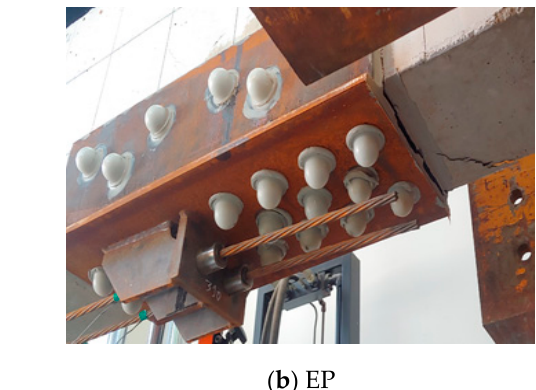
Figure 8. Load–displacement responses for strengthening methods for a concrete strength of 40 MPa for prestressing at 140 and 280 kN.